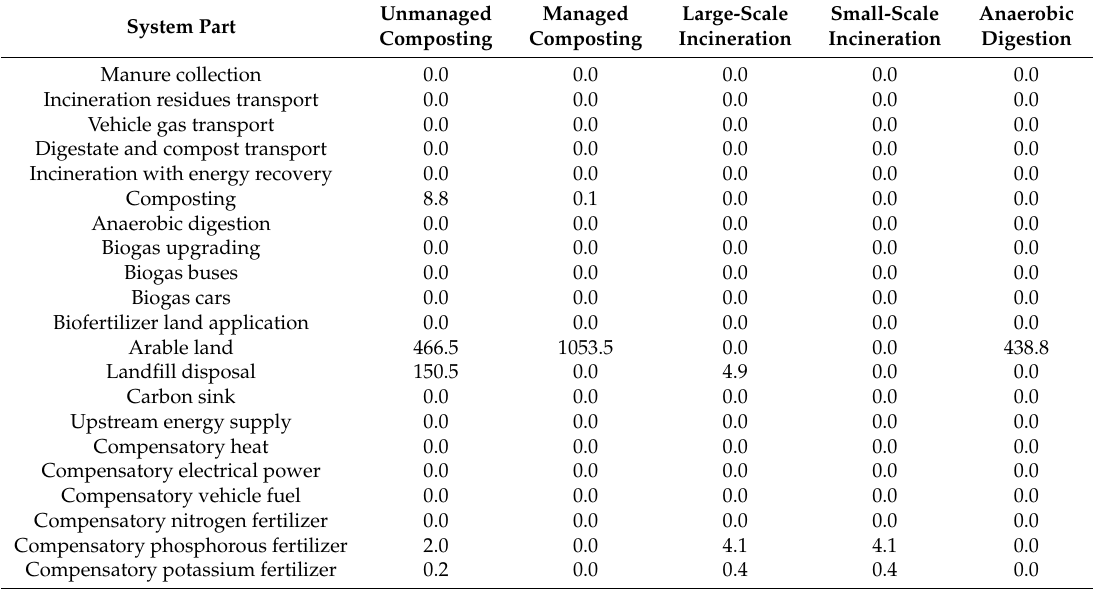
Table B5. Eutrophication Potential Water (kg PO 43 −